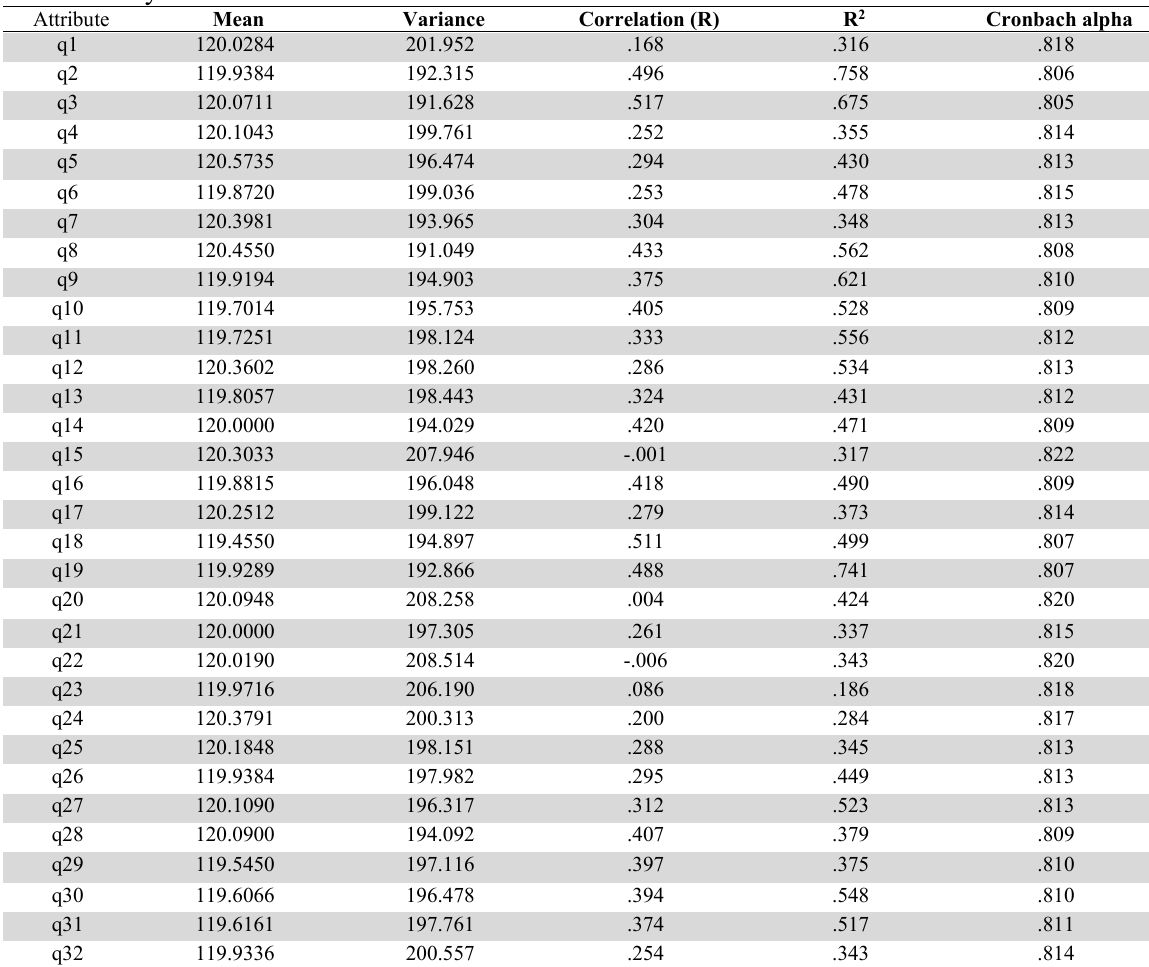
The summary of some basic statistics